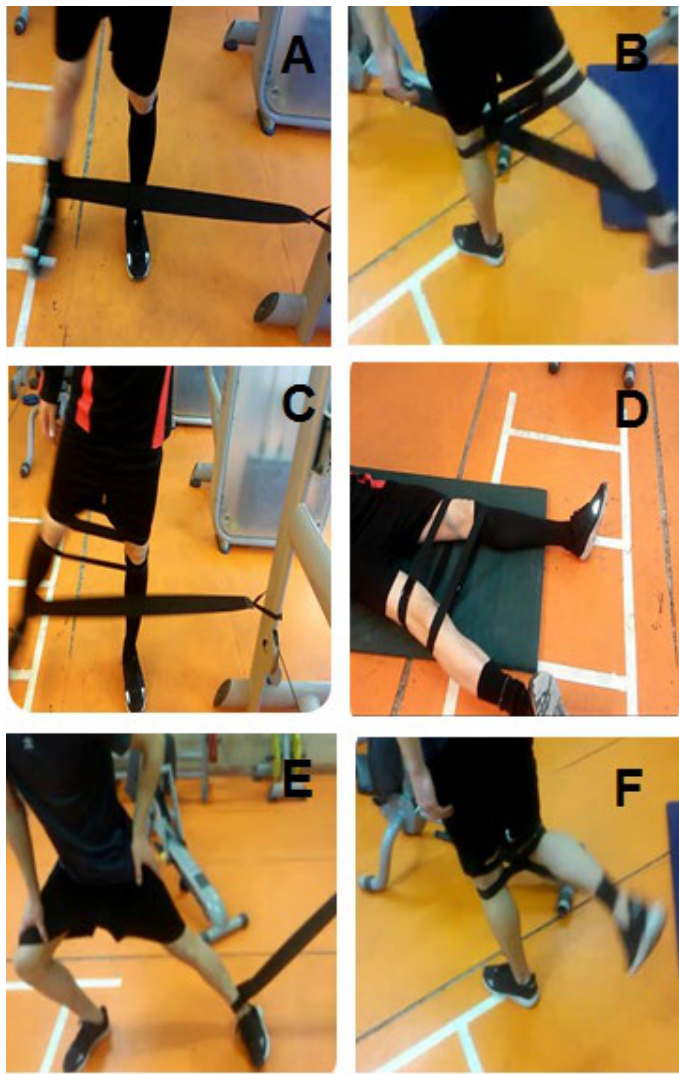
Figure 1. The exercises carried out during activation stage in training sessions. and repeated weekly for 8